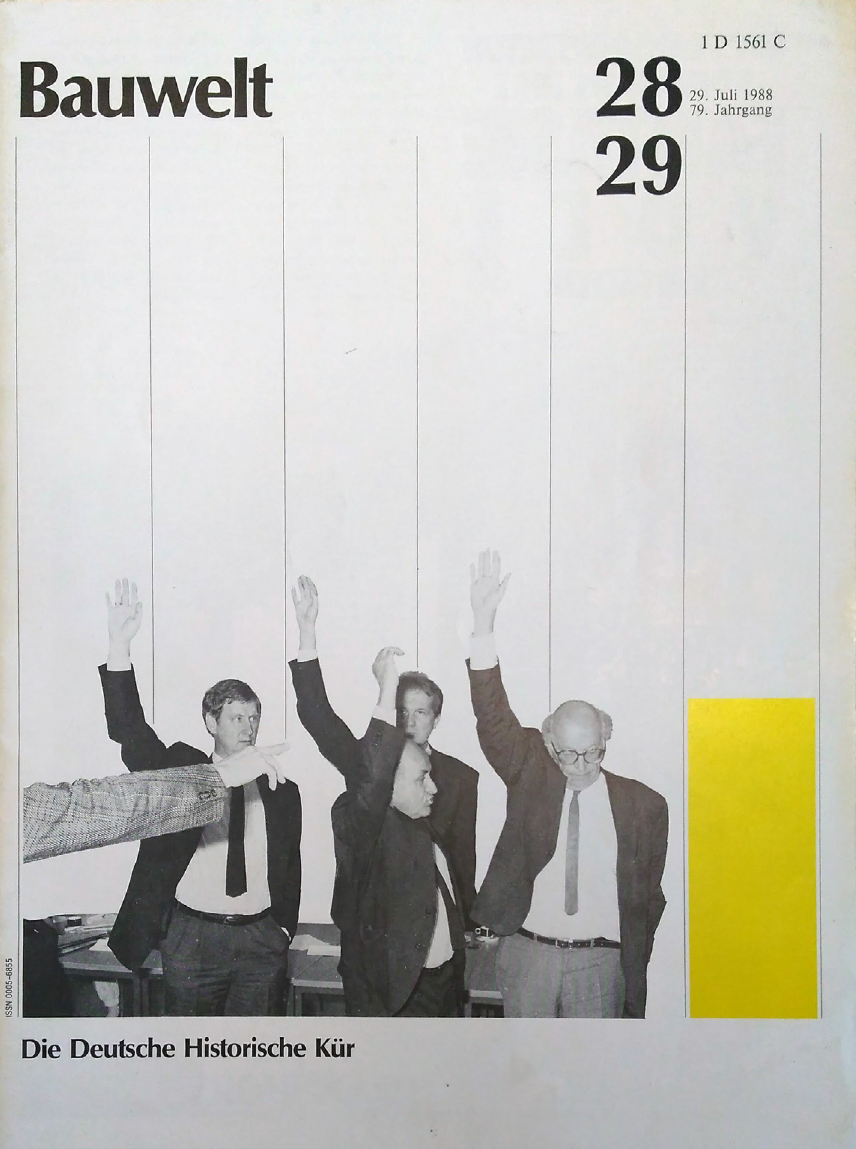
Issue of Bauwelt (Nr. 28–29, 1988) devoted to the DHM. The cover shows the jury with Max Bächer on the far